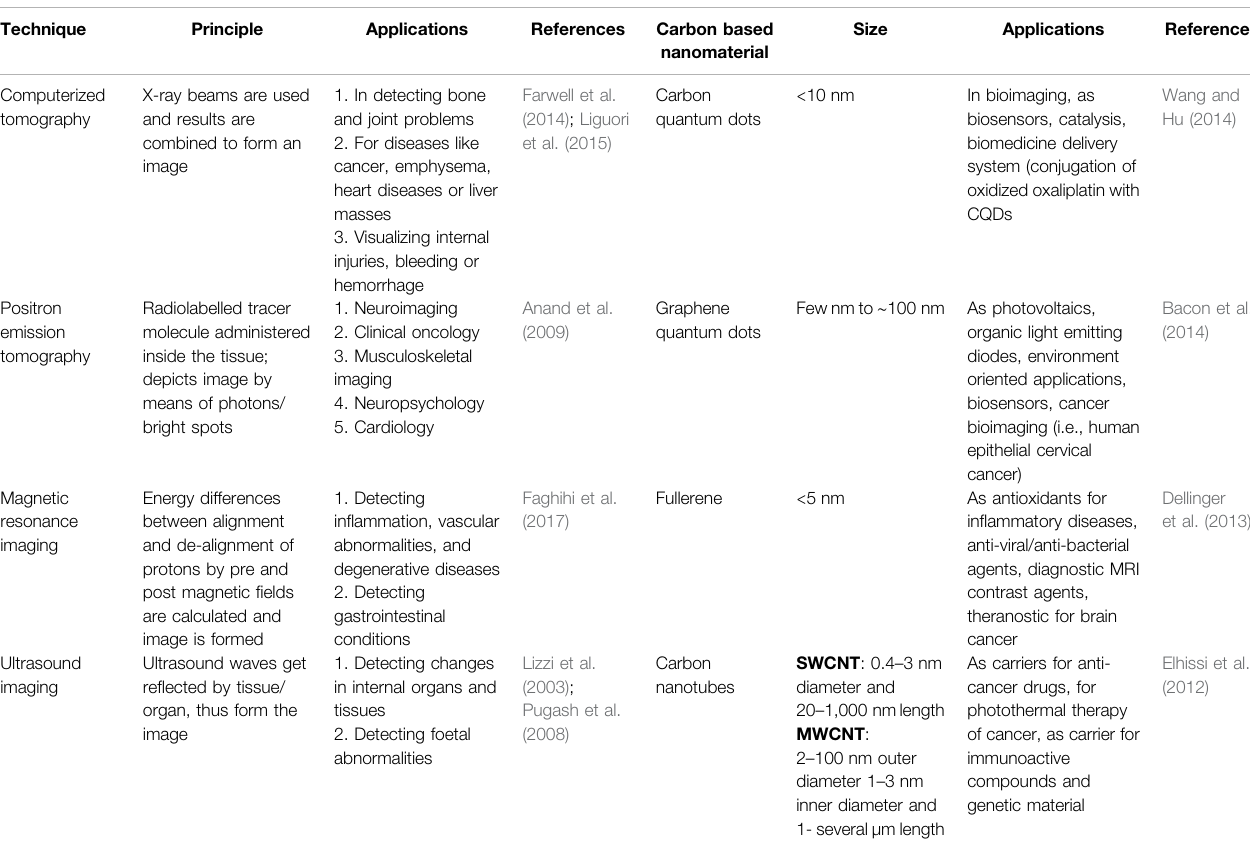
TABLE 1 | A comparative summary of different conventional techniques and carbon-based nanomaterials used in early diagnosis of